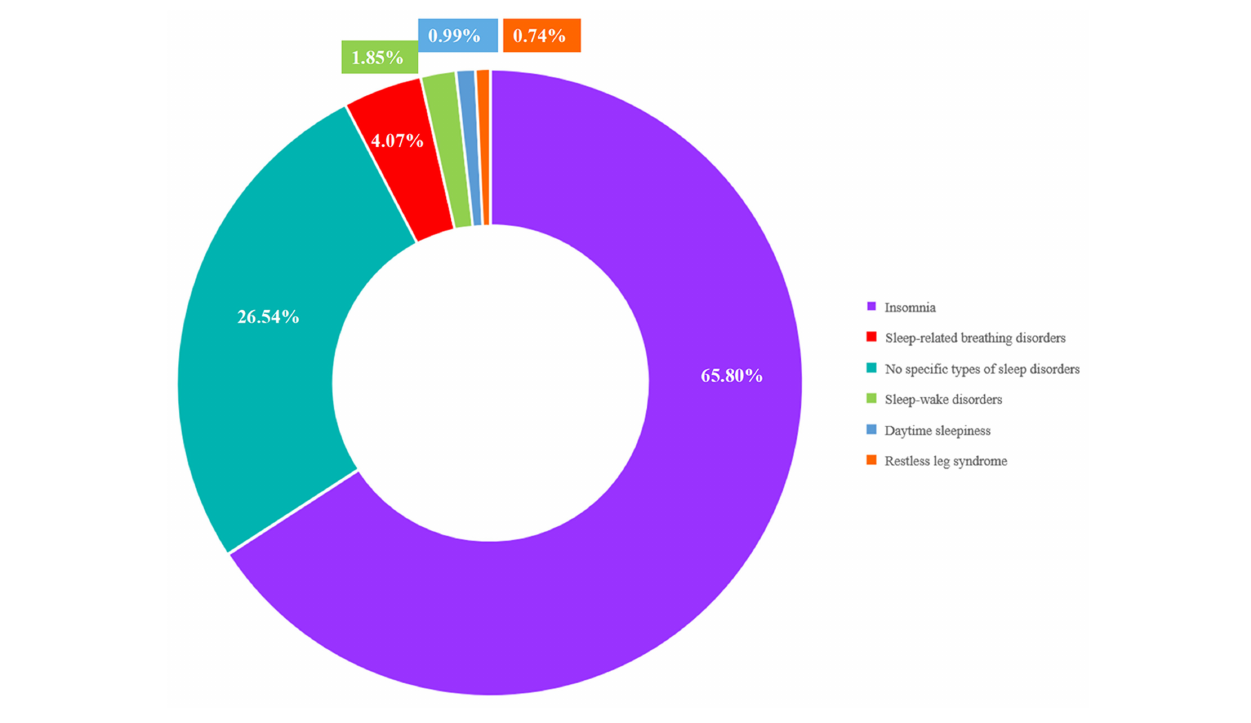
FIGURE 2 | The overview of evidence body per sleep disorders.